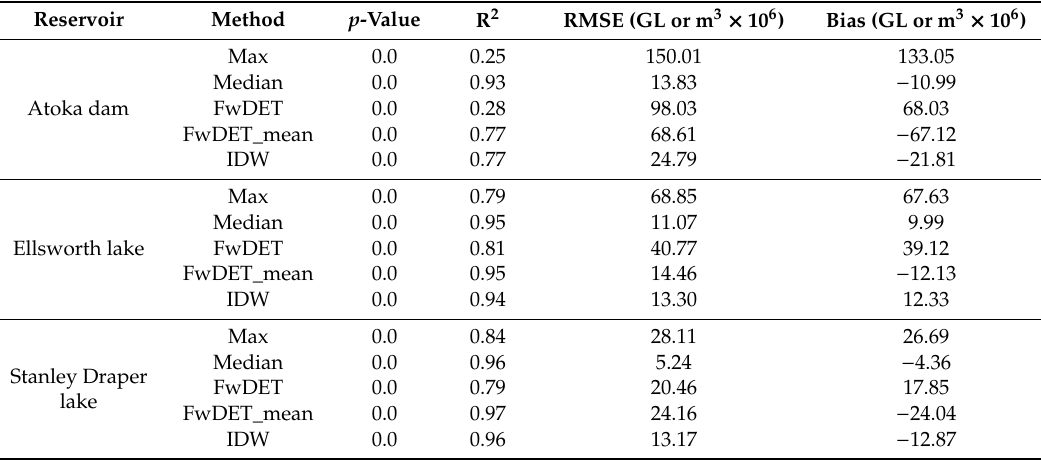
Table3. PerformanceofthedifferentmethodologiesusedtoestimatewatervolumesinOklahomareservoirs.